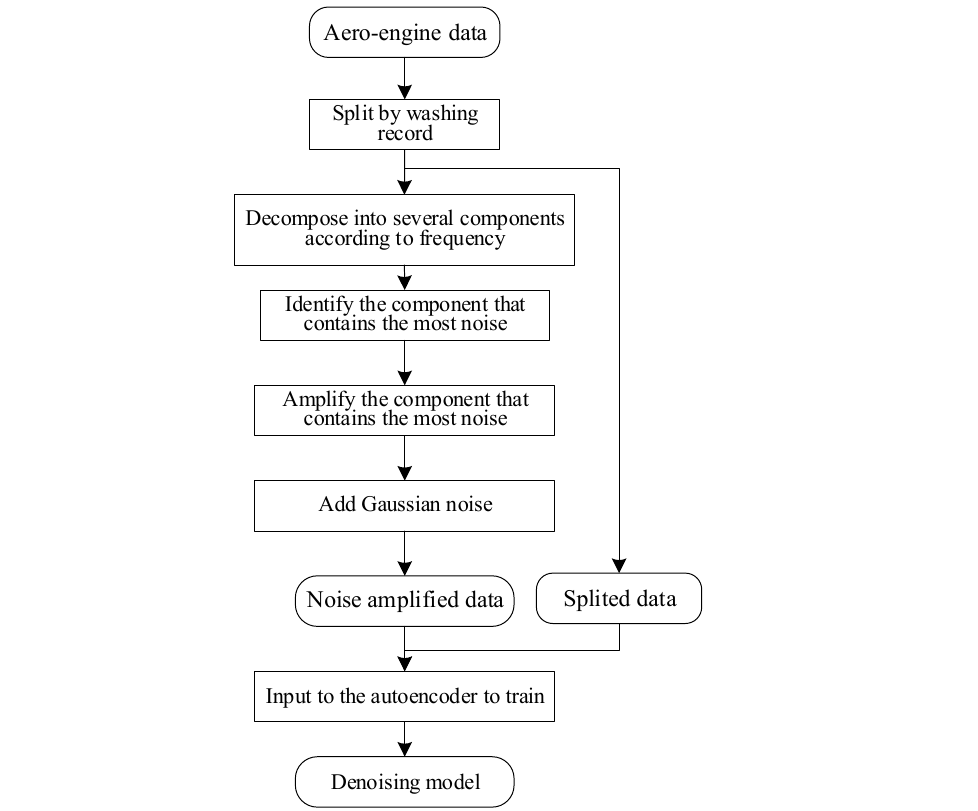
Figure 2. Denoising model principle.